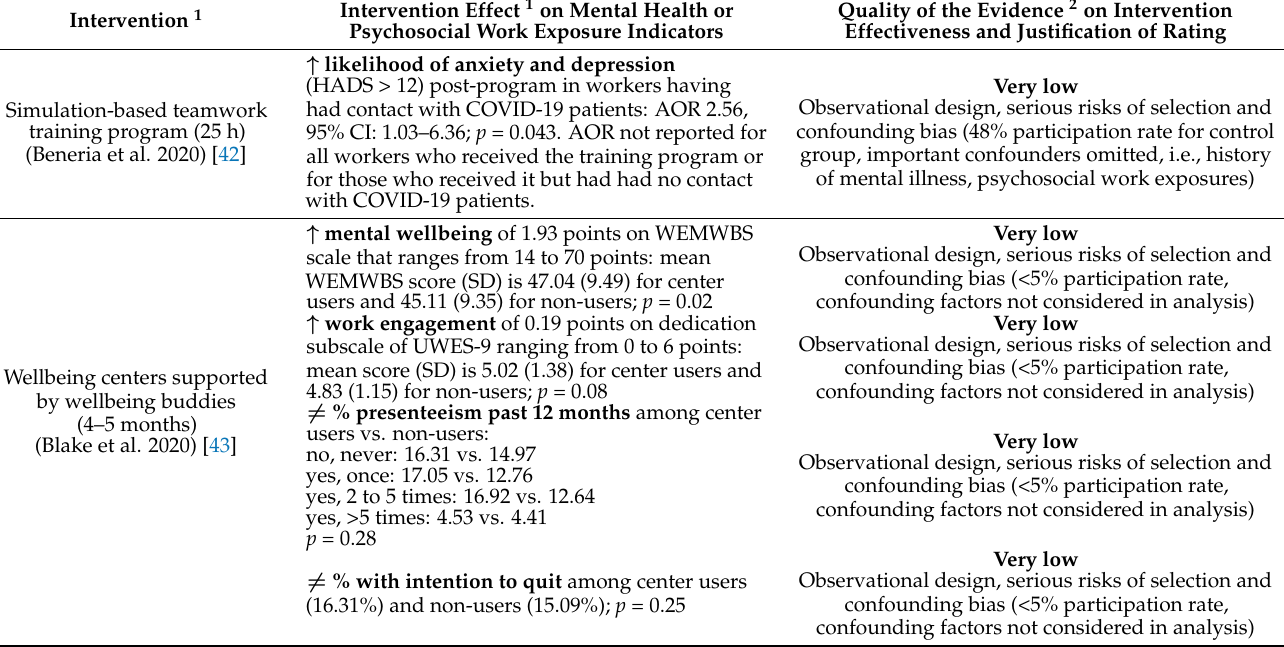
Table 2. Summary of intervention effects on mental health or psychosocial work exposure indicators and quality of the evidence on intervention effectiveness according to the Grading of Recommenda- tions Assessment, Development and Evaluation (GRADE)